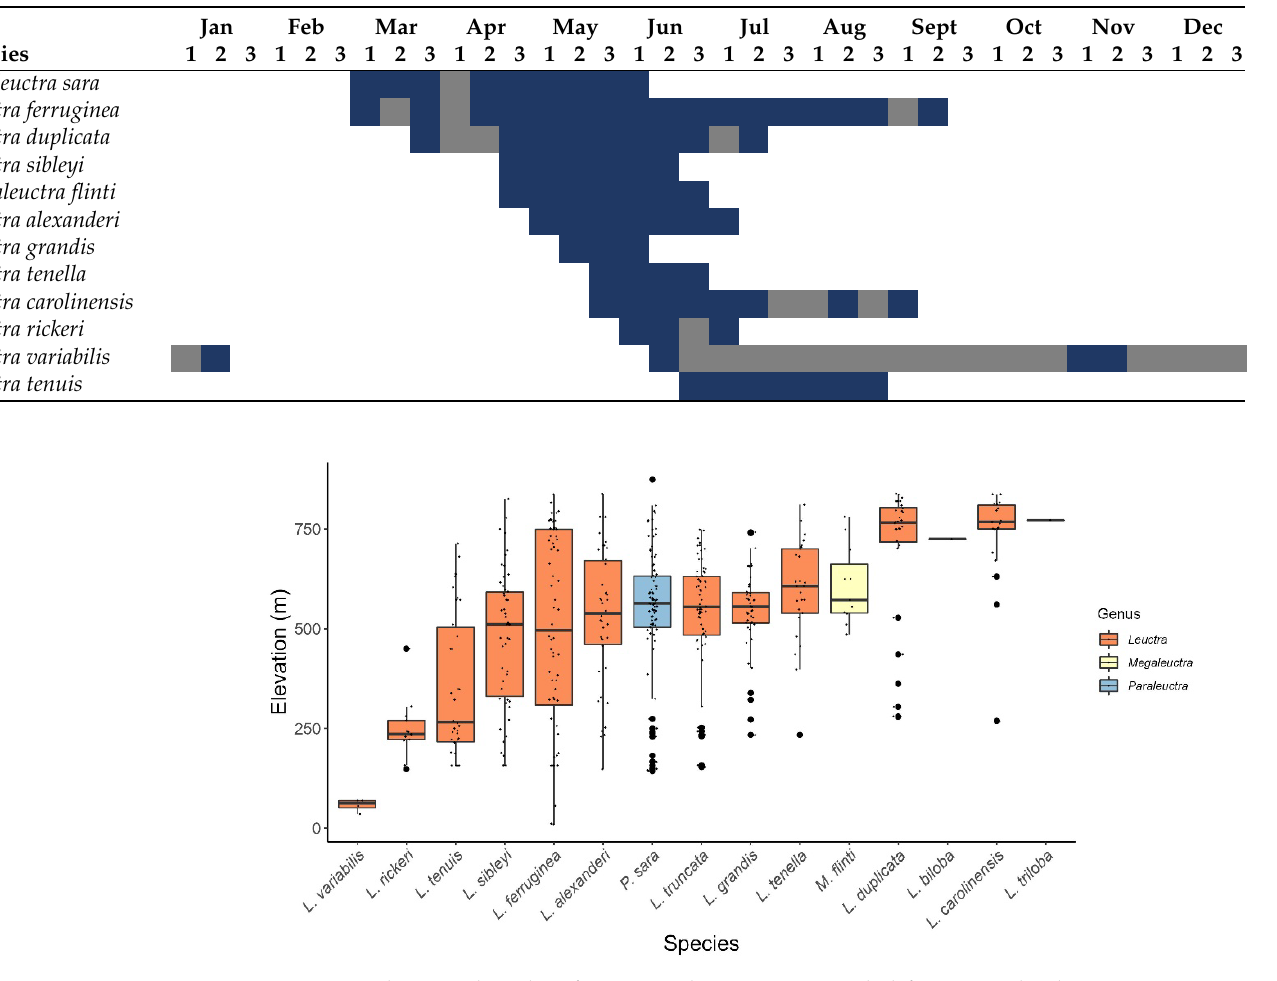
Figure 9. Elevation boxplots for Leuctridae species recorded from Maryland. Boxes represent the interquartile range, while vertical lines extend to the minimum and maximum values. The horizontal line within the interquartile range represents the median elevation. Outliers are shown with large, solid circles. Small, individual points overlaid on each boxplot illustrate the distribution of observations.